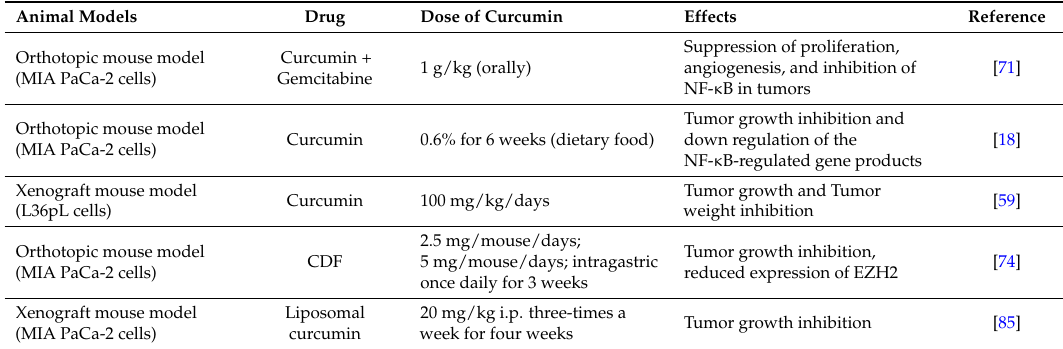
Table 2. Preclinical in vivo studies on the anticancer effects of curcumin against PC. Animal